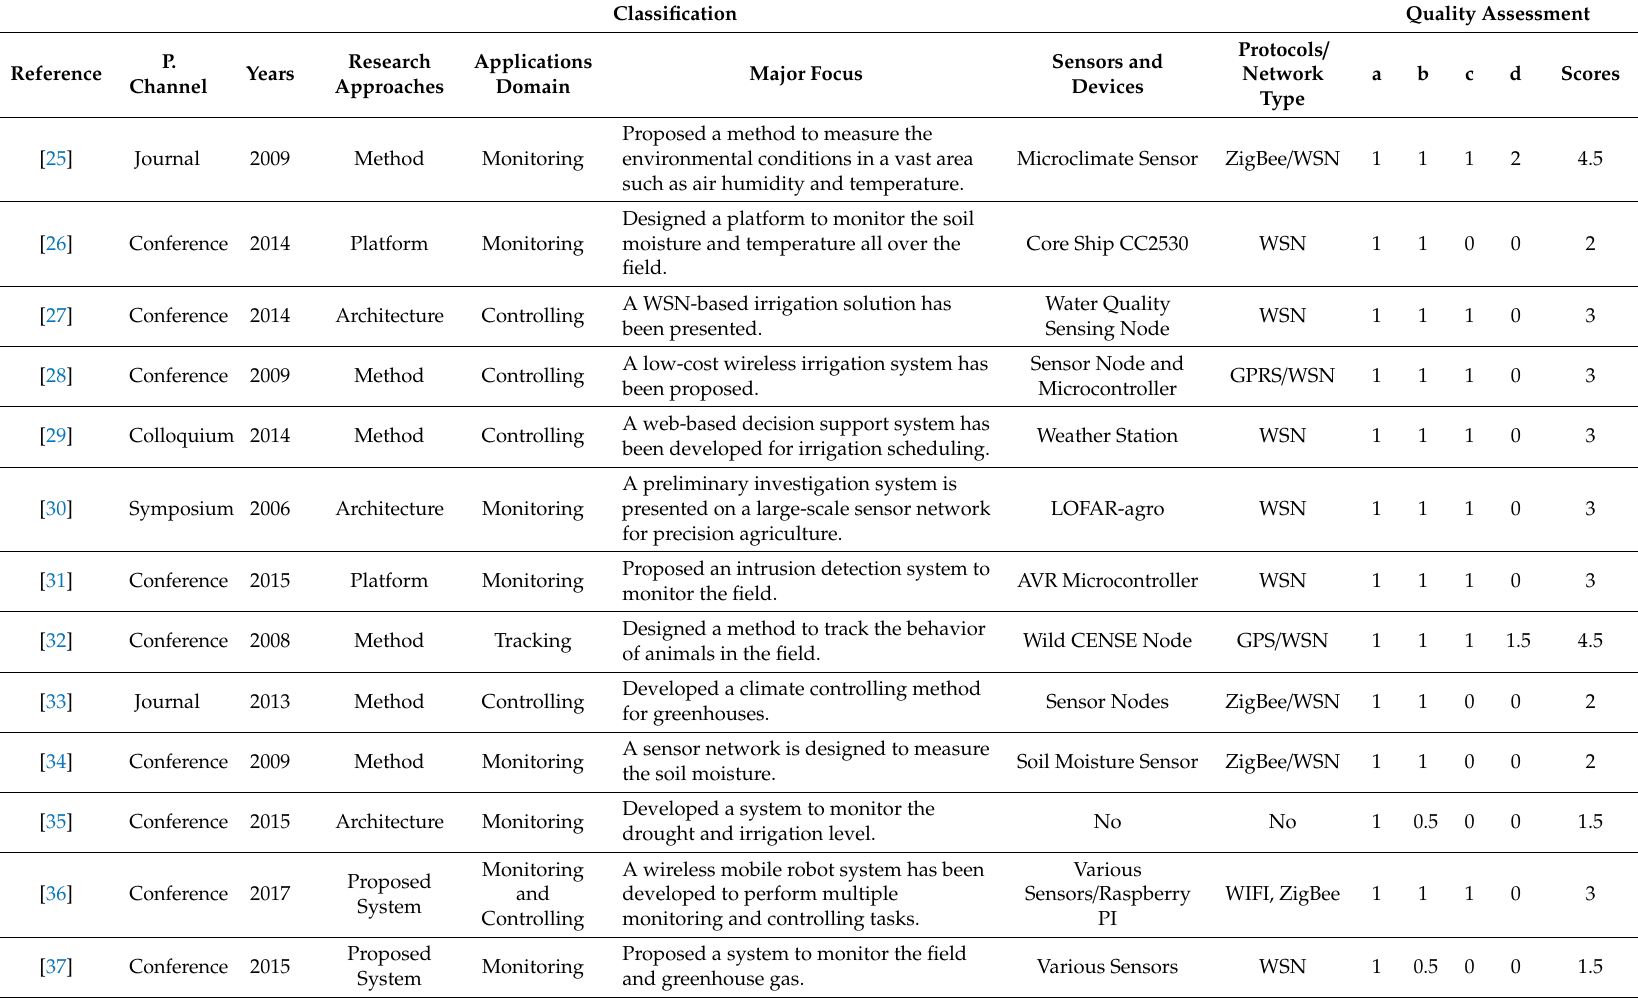
Table 5. Classification and quality assessment scores. WSN: wireless sensor